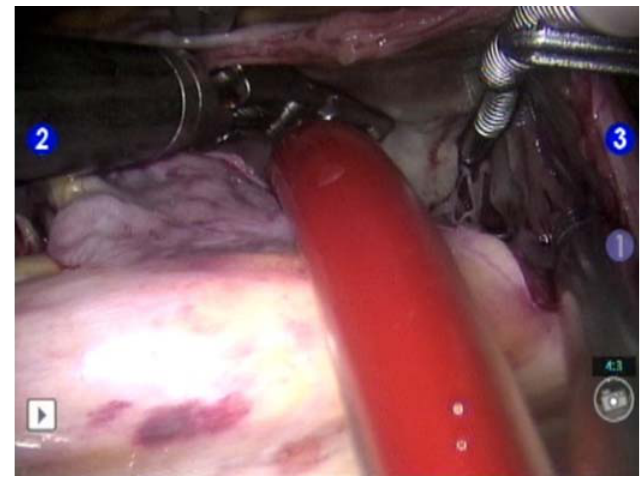
Figure 10. Lesion from right atriotomy to Tricuspid Valve annulus.